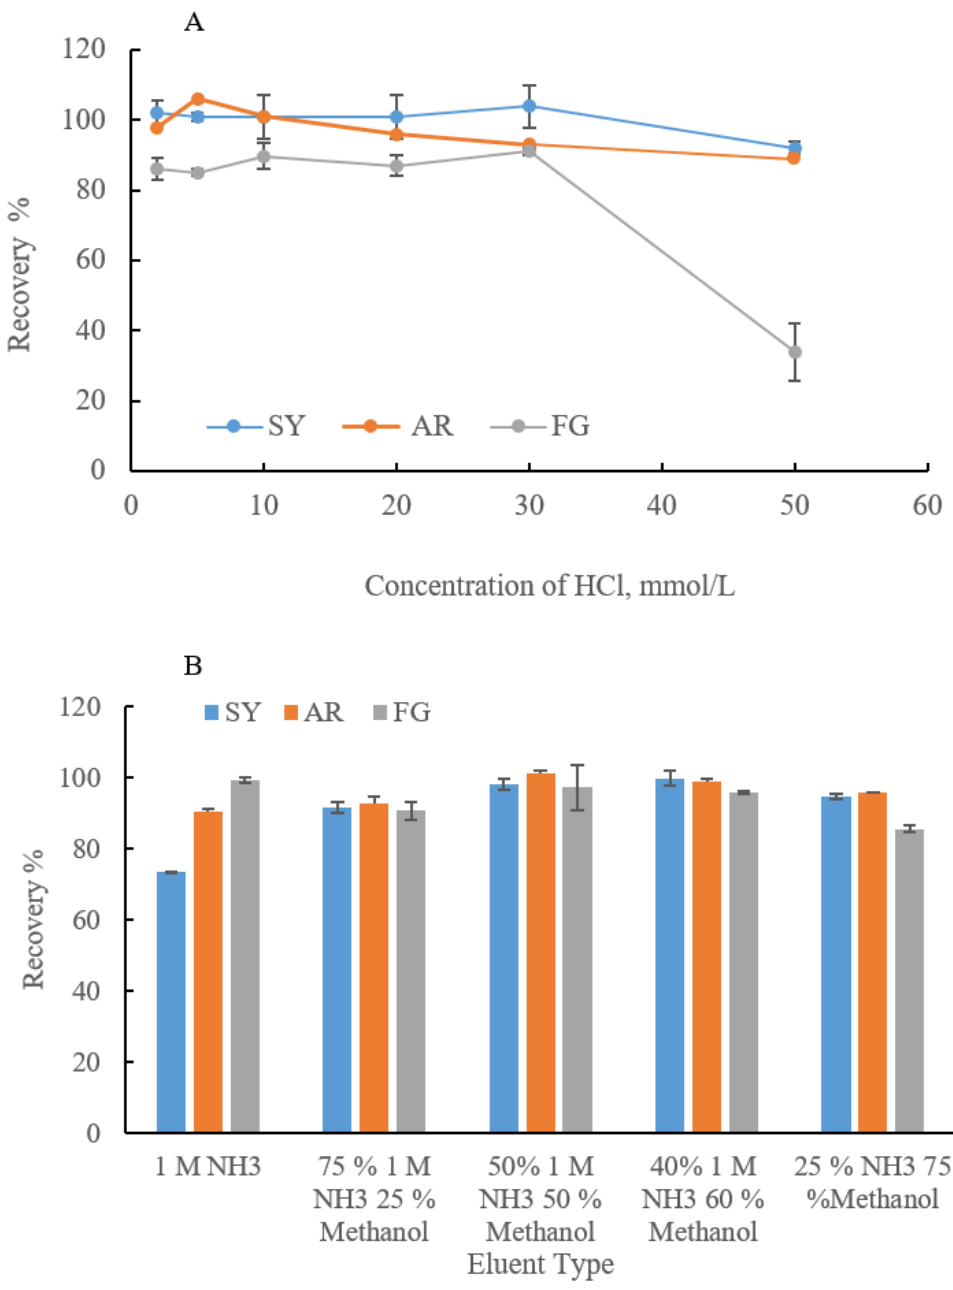
FIGURE 3A - Effect of HCl concentration on extraction of dyes ( 100 mg Fe eluent: 25% NH 75% Methanol) 3B - Effect of eluent types on recovery SY, AR and FG on Fe 3 mL of dyes containing 25 mL 10 mmol/ L HCl